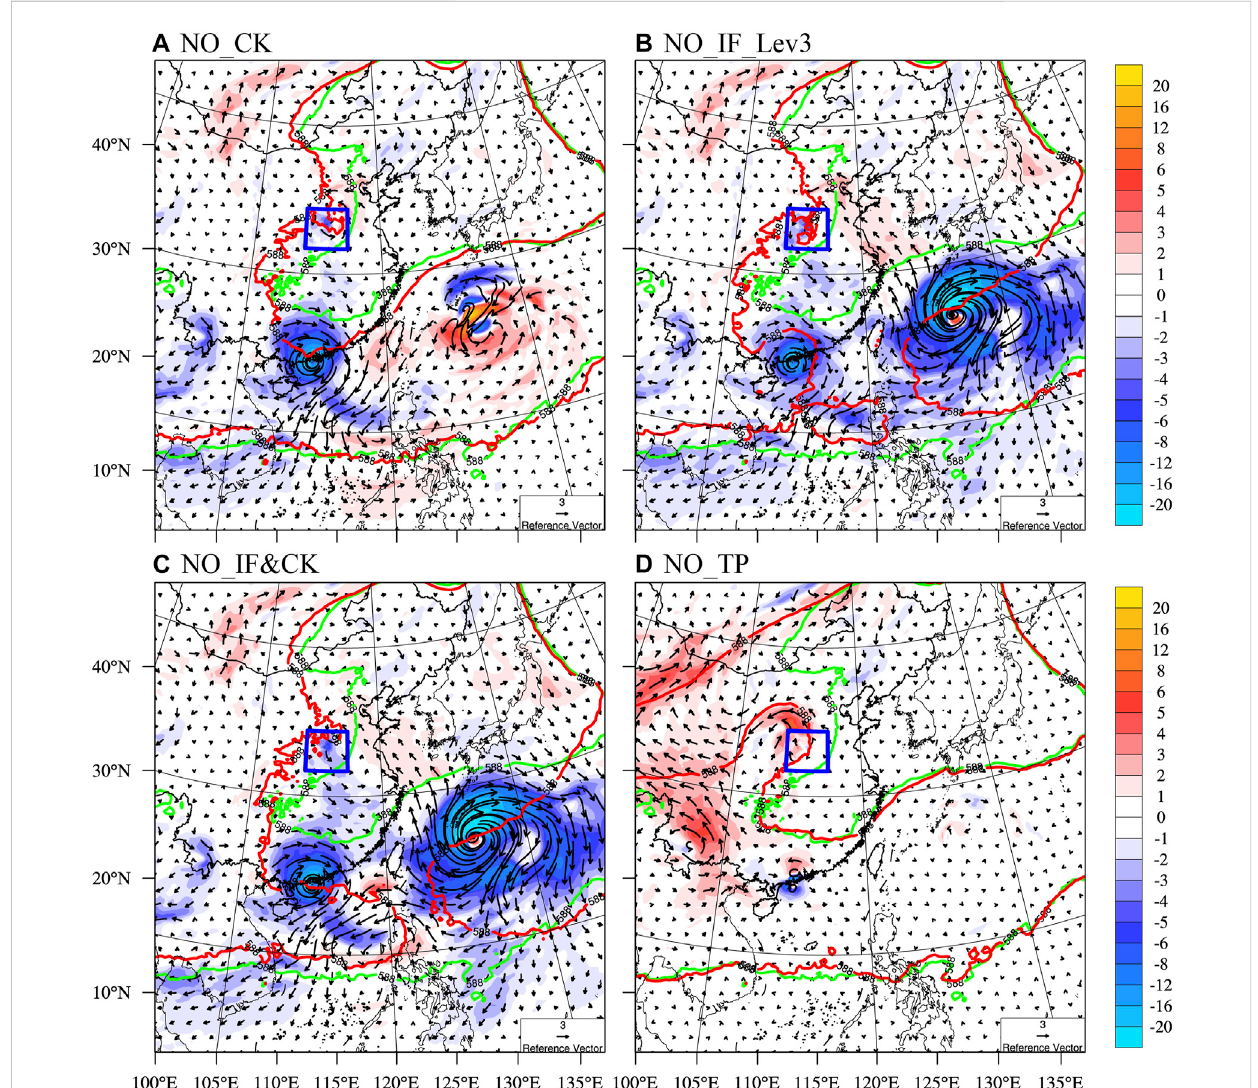
FIGURE 10 Deviation distribution fi eld of the vertically integrated water vapor fl ux (unit: kg m − 1 s − 1 ) of each sensitivity test compared with the CTRL test at 1800 UTC on July 20. (A) NO_CK (B) NO_IF_Lev3 (C) NO_IF&CK (D) NO_TP. The shading represents deviation of water vapor fl ux (sensitivity test minus ctrl test, unit: kg m − 1 s − 1 ) and the arrow represents the vector fl ux (unit: kg m − 1 s − 1 ). The green solid line represents the isoline of 588 dagpm geopotential height in the CTRL test, and the solid red line represents the isoline of 588 dagpm in the sensitivity tests. The blue box represents the key area associated with